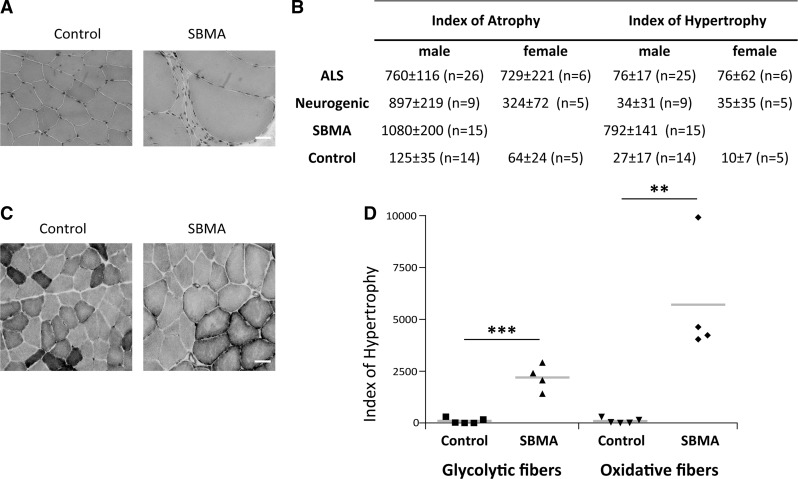
Atrophic and hypertrophic fibers in the skeletal muscle of SBMA patients. (A) Representative images of H&E-stained cryosections of control and SBMA quadriceps muscles. Scale bar, 40 µm. (B) Table showing the mean values of the atrophy and hypertrophy indexes in SBMA, ALS, and neurogenic patients and control subjects. The values, quantified as described in Materials and Methods, are expressed as mean ± SEM. Significance by ANOVA + LDS Fisher post doc: atrophy index: P < 0.001 SBMA, ALS and neurogenic atrophy patients versus controls; hypertrophy index: P < 0.001 SBMA versus controls, P < 0.001 SBMA versus ALS patients, P < 0.001 SBMA versus neurogenic patients. (C) Representative NADH-stained quadriceps muscle sections of control and SBMA subjects. Scale bar, 80 μm. (D) Analysis of the hypertrophy index in oxidative and glycolytic fibers. Graph, mean ± SEM, n = 4 SBMA patients and 5 control subjects. Significance by Student’s t test: **P < 0.01, ***P < 0.001.